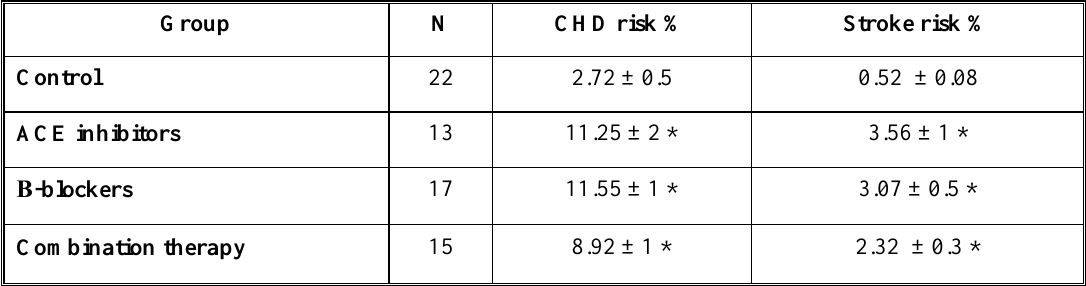
* P ≤ 0.05 significant difference from the control. Table 12: CHD risk % and stroke % based on SBP in control healthy individuals and retrospective diabetic hypertensive patients treated with different antihypertensive drug regimens. Each value represents mean± standard error of mean.